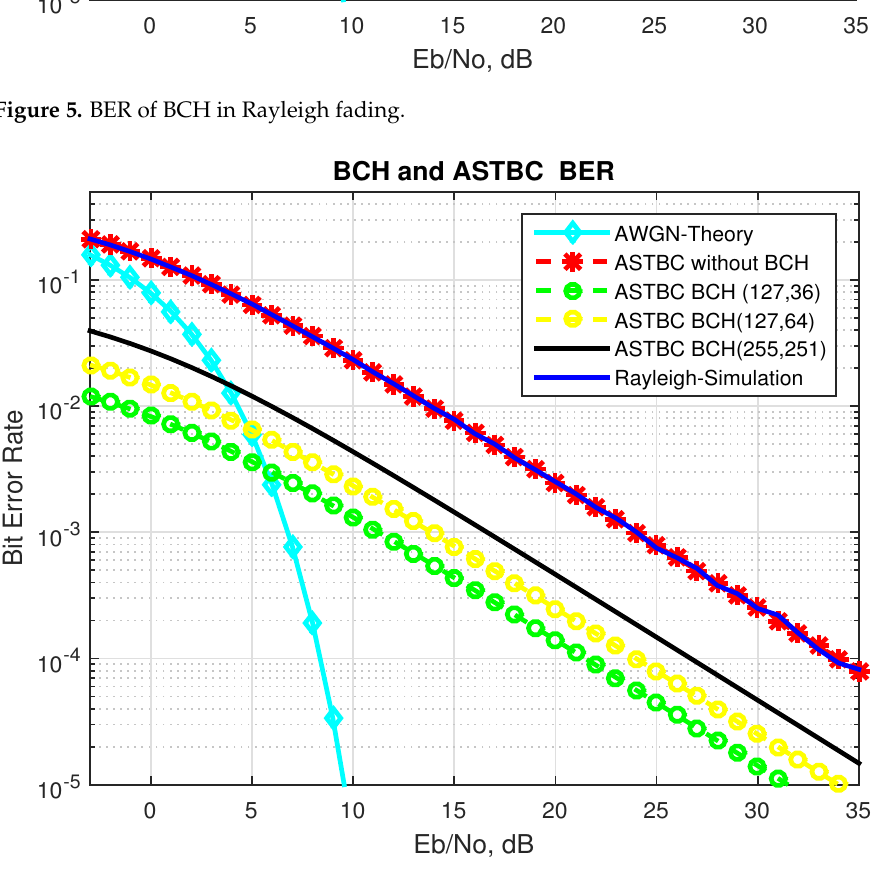
Figure 6. BER of